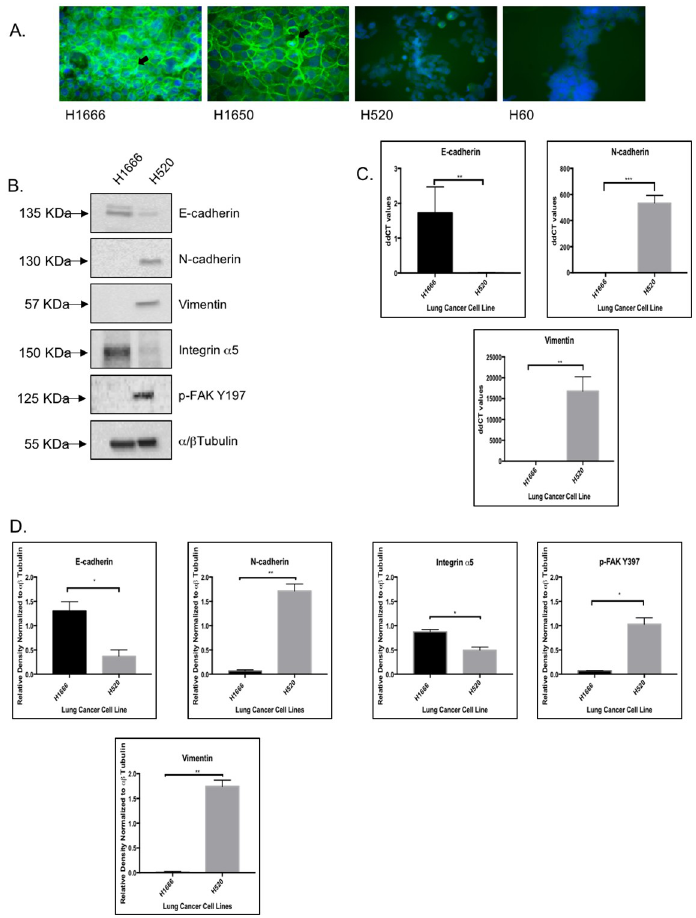
Fig 1. The H520 cell line lacks adherens junctions and expresses EMT traits. (A) E-cadherin immunofluorescence showing membrane-associated E-cadherin localization ( arrows ) in H1666 and H1650 cells. In contrast, E-cadherin expression is notably decreased in H520 cells in a diffuse cytoplasmic staining pattern. E-cadherin expression is undetectable in SCLC H60 cells. In all preparations nuclei were counterstained with DAPI (blue). (B) Representative immunoblots showing decreased E-cadherin, increased N-cadherin and vimentin, decreased integrin α 5 expression and increased FAK phosphorylation on Tyr397 in H520 cells relative to H1666 cells. Immunoblot using an anti α / β tubulin antibody ( bottom panel ) shows equal loading of the gel. (C) EMT marker expression was also measured at the mRNA level by qRT-PCR. While levels of the E-cadherin transcript are elevated in H1666 relative to H520 cells, the levels of N-cadherin and vimentin transcripts are elevated in H520 cells relative to H1666 cells, in all three instances in a statistically significant manner. Error bars are standard error of the mean, and P-values are shown on top of each graph. (D) Immunoblot replicas were quantified by densitometric analyses of band intensity. Bars represent band intensity for each protein, normalized against the α / β tubulin loading control, and error bars are standard error of the mean. P values, shown on top of each graph, indicate that all the observed changes in protein expression were statistically significant. Statistical tests were assessed by Mann-Whitney tests when comparing two groups and Kruskal Wallis when comparing three groups or more. Statistical significance was defined as, � p-value < 0.05, �� p- value < 0.01, and ��� p-value < 0.001. relative to H1666 cells (Fig 1B and 1C), indicative of the cadherin switch known to occur during EMT. Increased vimentin expression, another EMT trait, is also observed in H520 cells relative to H1666 (Fig 1B and 1C). We also checked for markers of cell-to-substrate adhesion by immunoblot analysis. Expression of integrin α 5, a subunit of the fibronectin receptor, is diminished in H520 cells relative to H1666 cells, while the opposite is observed for phosphorylated focal adhesion kinase (FAK), a cytosolic protein tyrosine kinase that